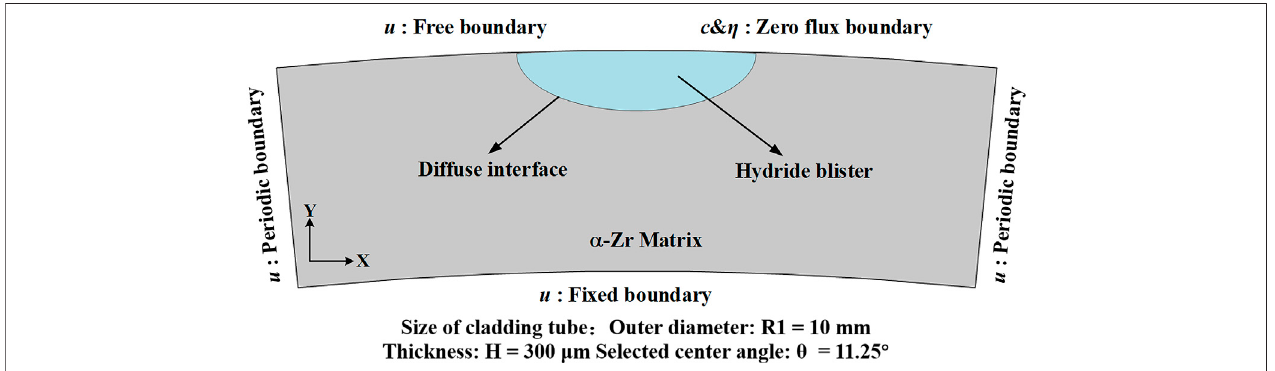
FIGURE 1 | Schematic diagram of zirconium-zirconium hydride blister model and boundary condition